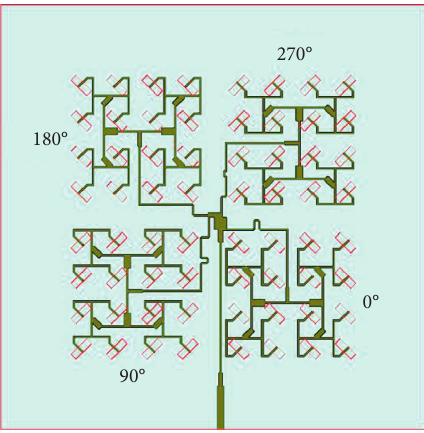
Figure 9: Structure of the feeding